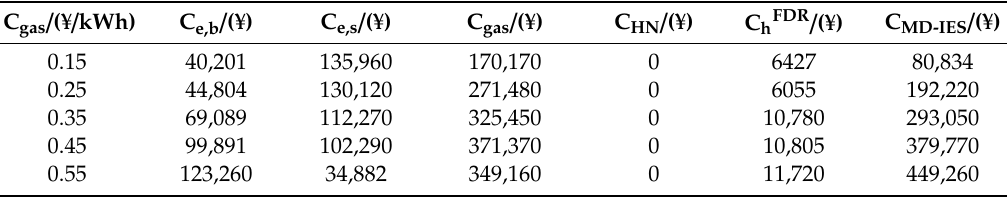
Table 8. Relation between the total operating cost and the price of natural gas without the heating network when C e,s = 0.7 ¥ /